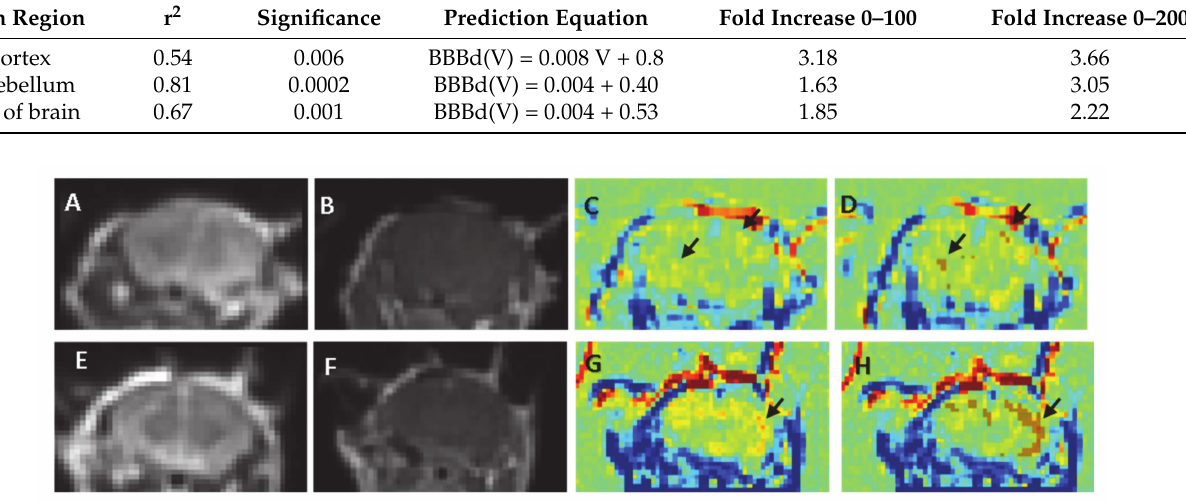
Figure 3. MRIs of a sham mouse and a mouse from the 100 V, 100 pulses group ( A – D ). Sham, ( E , F ). 100 V, 100 pulses ( A ) + ( D ). Table 2. MRIs showing no signs of damage or edema ( B ) + ( F ). Contrast-enhanced T1-MRI showing no visible enhancement in the brain parenchyma. ( C ) + ( G ). TRAMs calculated by subtracting the first T1-MRI from the 30 min T1-MRI. No clusters of contrast accumulation are visible in the sham mouse (( C ), arrow shows scattered pixels), while contrast accumulation is visible in the cortex (arrow) of the treated mouse ( G ). ( D ) + ( H ) The results of the analysis algorithm showing random small clusters in the sham brain (brown pixels) and significant BBBd clusters (mainly in the cortex) in the treated